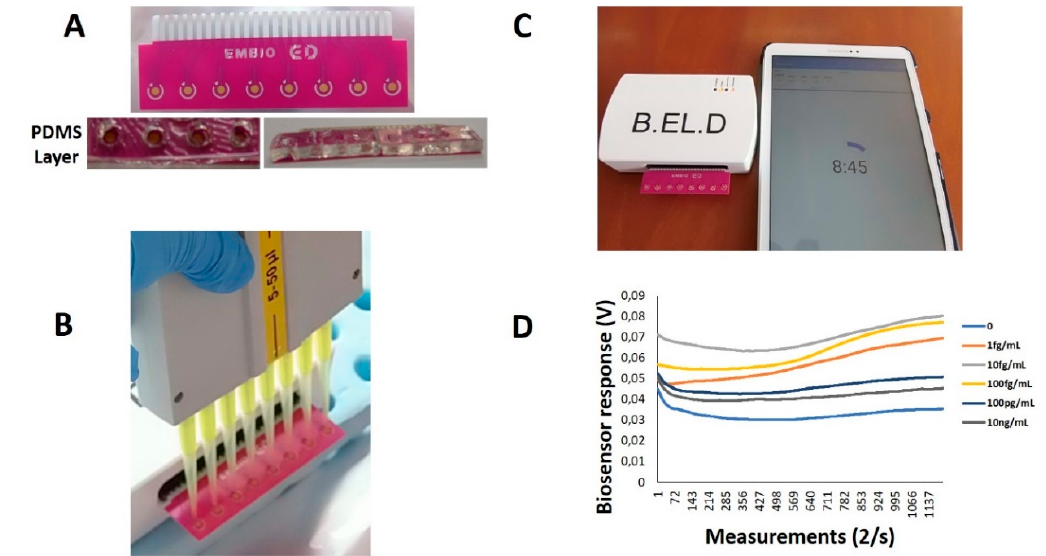
Figure 1. Experimental set-up of the Vero/anti-S1 cell-based biosensor’s assembly. An eight-channel gold screen-printed electrode assembly was prepared with the PDMS layer attached for the well formation ( A ). The potentiometer device is connected to a tablet device for the recording of the measurements immediately after the sample application ( B , C ). The electric signal is visualized through a voltage vs. time graph ( D ).